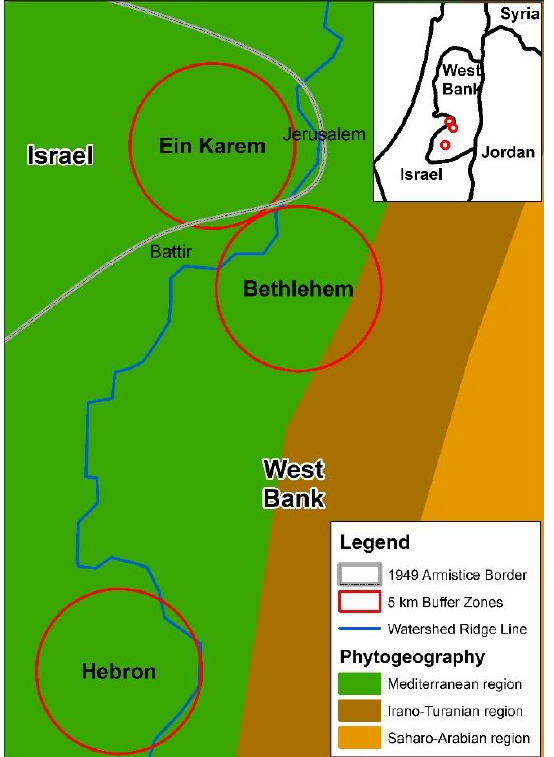
Figure 1. The three research areas—Ein Karem, Bethlehem, and Hebron. Each research area is circled in red, which delineates a 5 km radius from the main settlement outwards. The watershed ridge line of the Judaean and Samarian mountains and the phytogeographical regions are also shown (the phytogeographical regions were made on the basis of the 1984 Floristic Regions of the Land of Israel map [34]).